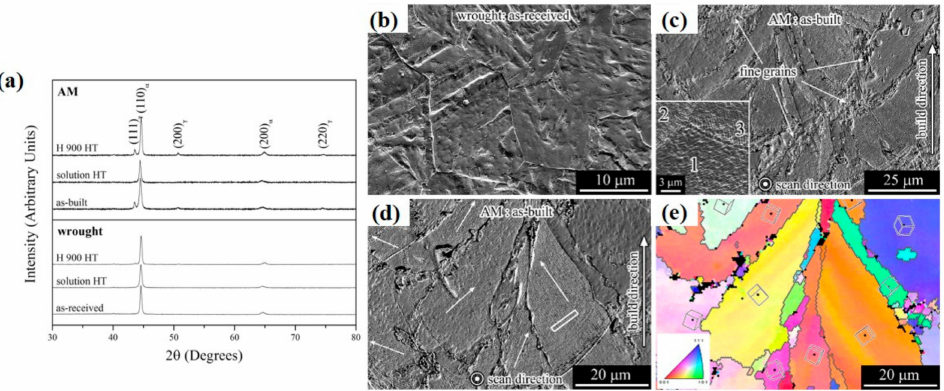
Figure 3. ( a ) XRD spectra of the as-built and heat-treated 17–4 PH SS samples, ( b ) as-received wrought sample, and ( c ) as-built sample; ( d ) a typical melt pool in the as-built sample. ( e ) An EBSD grain orientation map obtained from the area shown in Figure 3d